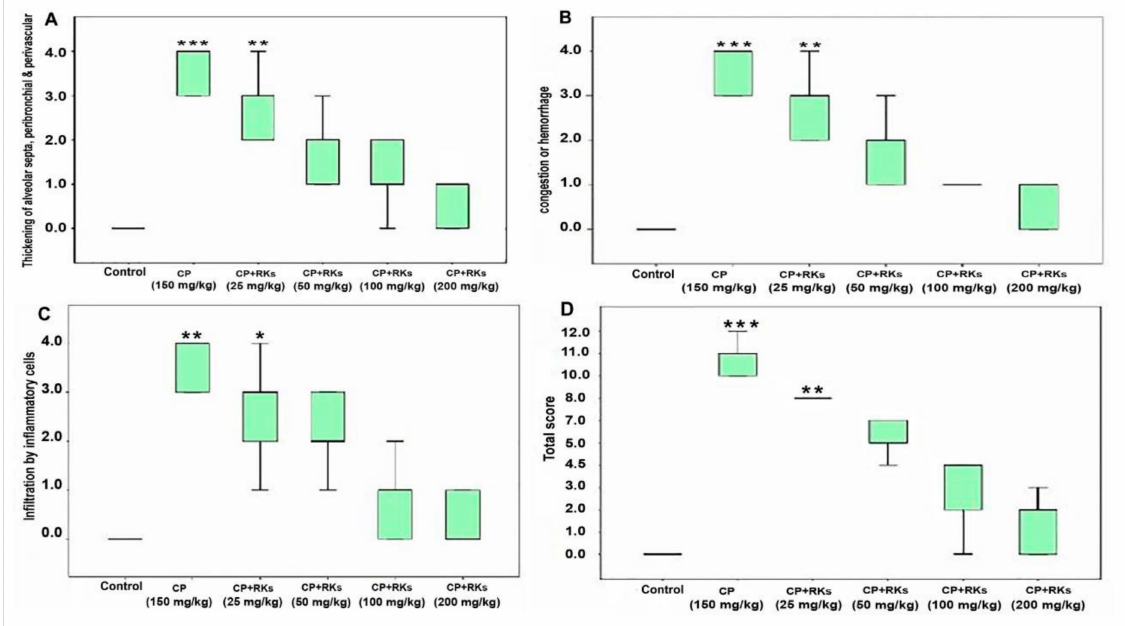
Figure 2. Boxplots showing scores of ( A ) thickening of alveolar septa, peribranchial and perivascular, ( B ) scores of congestion or hemorrhages, ( C ) scores of infiltrations by inflammatory cells and ( D ) the total scores of thickening (of alveolar septa, peribranchial and perivascular). All boxplot graphs treatment with di ff erent concentrations of RKs (25, 50, 100, 200 mg / kg / p.o.). Di ff erence between groups was assessed using independent samples Kruskal-Wallis Test, followed by Kruskal-Wallis pairwise comparisons ( n = 4–6). Asterisks denotes significant di ff erent versus CP (150 mg / kg) (*) significant at p < 0.05; (**) highly significant at p < 0.01; (***) very high significant at p <